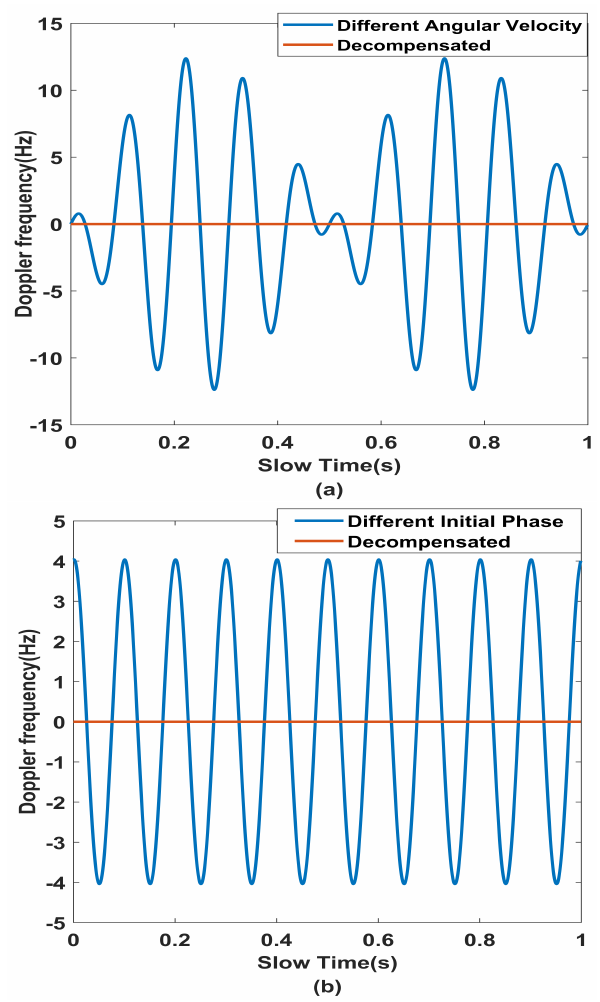
Figure 4. The result between the different sine functions after compensation: ( a ) compensated result of different angular velocity and ( b ) compensated result of different initial